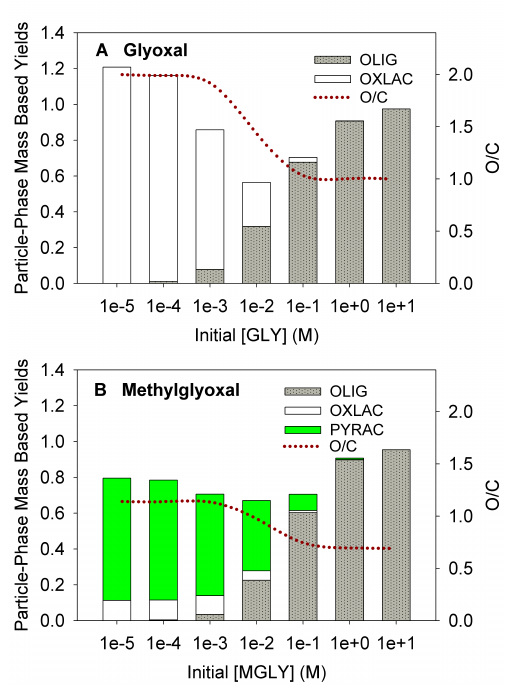
Fig. 9. Atmospheric batch simulations (A) for particle-phase mass- based yields of oxalate ( Y OXLAC ) , oligomers ( Y OLIG ) , and SOA ( = Y OXLAC + Y OLIG ) with increasing initial concentrations of gly- oxal ( x axis) for aqueous-phase OH radical reactions, and (B) for particle-phase mass-based yields of oxalic acid ( Y OXLAC ) , pyruvate ( Y PYRAC ) , oligomers ( Y OLIG ) , and SOA ( = Y OXLAC + Y PYRAC + Y OLIG ) with increasing initial concentrations of methylglyoxal ( x axis) for aqueous-phase OH radical reactions. Similarly, O/C (on the right-hand y axis) vs. initial concentrations of glyoxal (A) and O/C vs. initial concentrations of methylglyoxal (B)